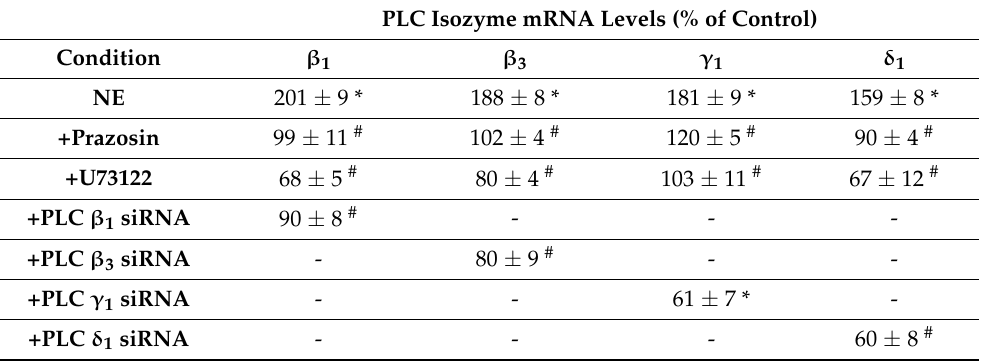
Table 4. Attenuation of the increases in phospholipase C gene expression due to norepinephrine by pharmacological and gene silencing interventions. PLC Isozyme mRNA Levels (% of Control)